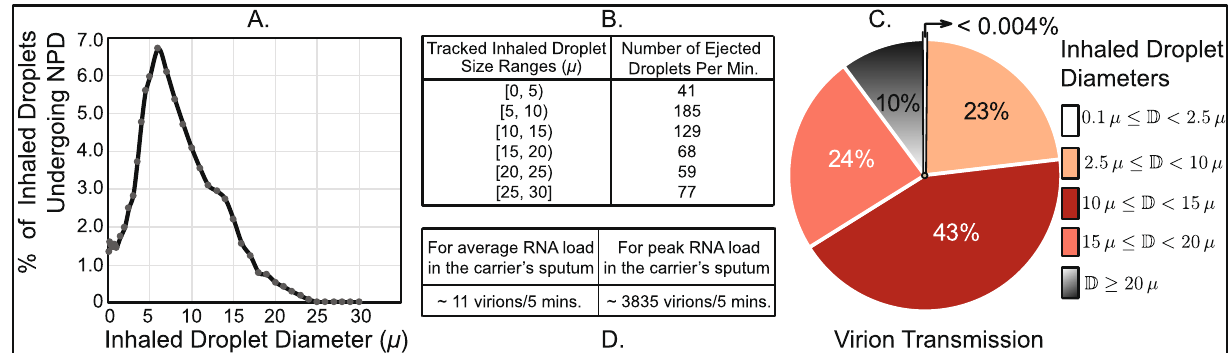
Figure 5. Quantifying virion transmission to the nasopharynx: ( A ) Graphical representation of the flow-averaged data on the percentage of droplets of each size undergoing deposition at the nasopharynx. ( B ) Distribution of droplet sizes ejected each minute during normal speaking, the numbers are calculated from earlier studies on expelled droplet tracking with food coloring 7 ; the reported size distribution is for dehydrated droplets. Also note that the referenced article 7 described the size bin limits as α − β (in µ ). For consistency, we typically interpreted that as droplet sizes (in µ ) that are ≥ α and < β ; and in this graphic, such a droplet size bin range is represented by [ α , β) , conforming to set theory notations. ( C ) Pie diagram showing which droplet sizes are dominant contributors for virion transmission at the nasopharynx, for ejecta size distribution as in ( B ). Symbol D is the inhaled droplet diameter. The numbers assume that the droplets have undergone dehydration before being inhaled into the nasal airspace. ( D ) Estimated number of virions that are deposited at the susceptible individual’s nasopharynx via dehydrated inhaled droplets, during close-range exposure to a COVID- 19 carrier for 5 min. Outputs in ( A – D ) in the above graphic respectively correspond to the steps marked by labels A – D in Fig. 2. The plots on ( A , C ) are generated using Microsoft Excel 365; link to softw are homep